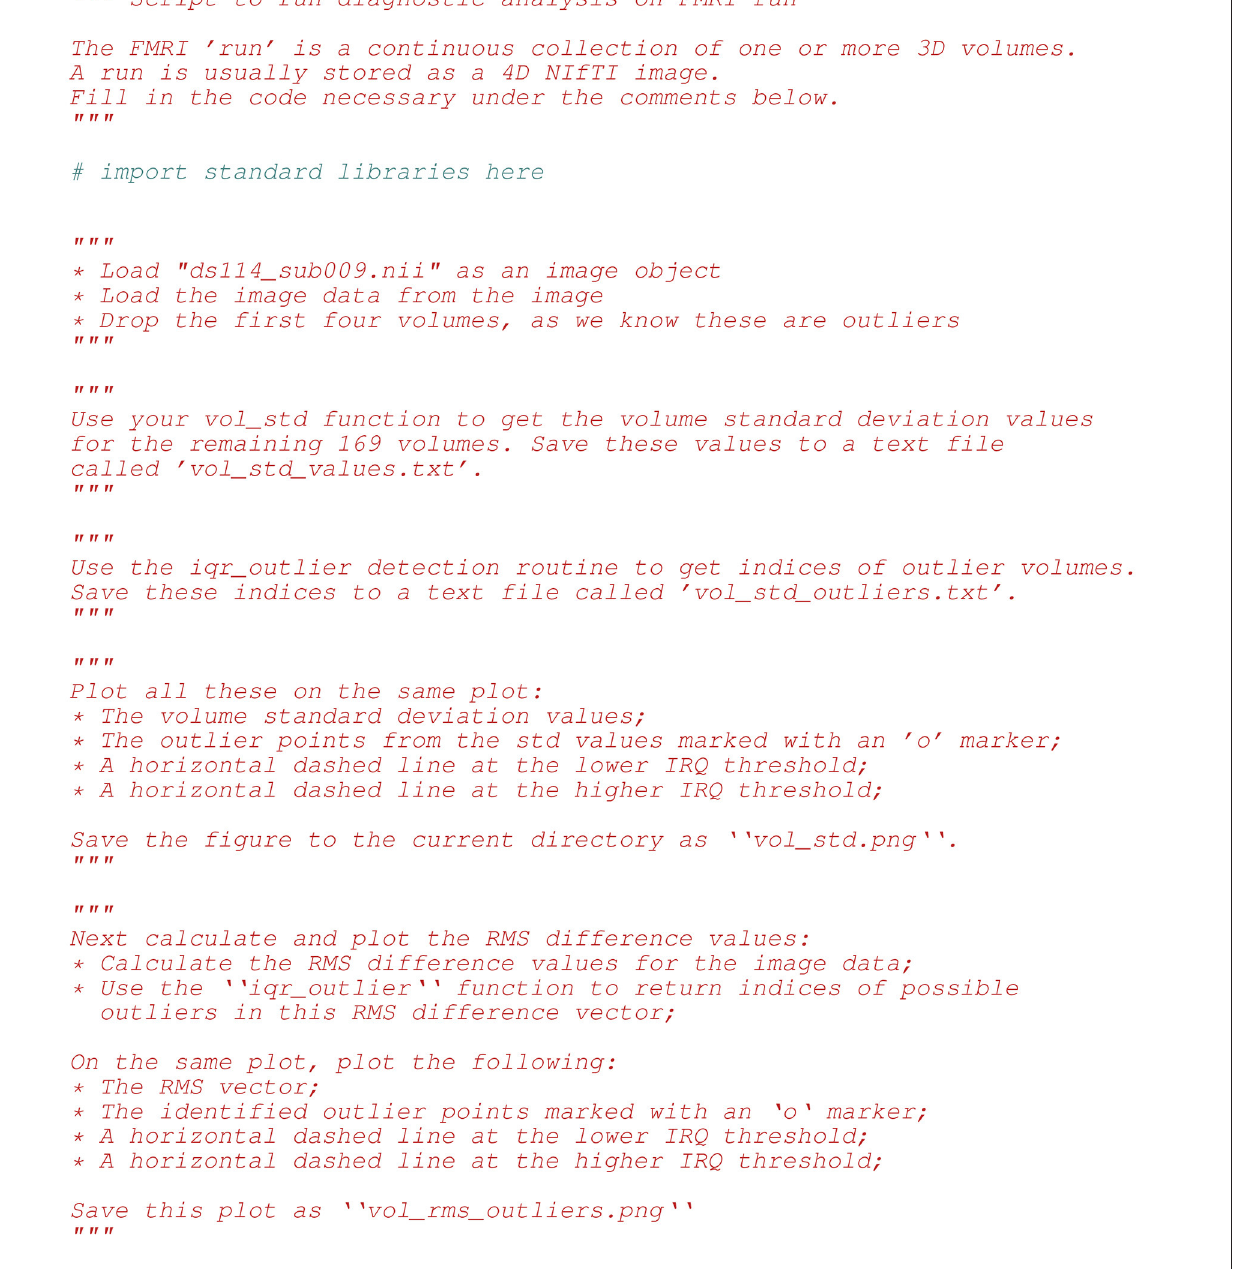
FIGURE 3 | Above we list the first few lines of diagnosis_script.py . This file was part of the second homework, which focused on detecting outlier 3D volumes in a 4D FMRI image. Tasks included: (a) implementing functions on image arrays using NumPy, (b) exploring FMRI data for outliers, (c) running least-squares fits on different models, and (d) making and saving plots with